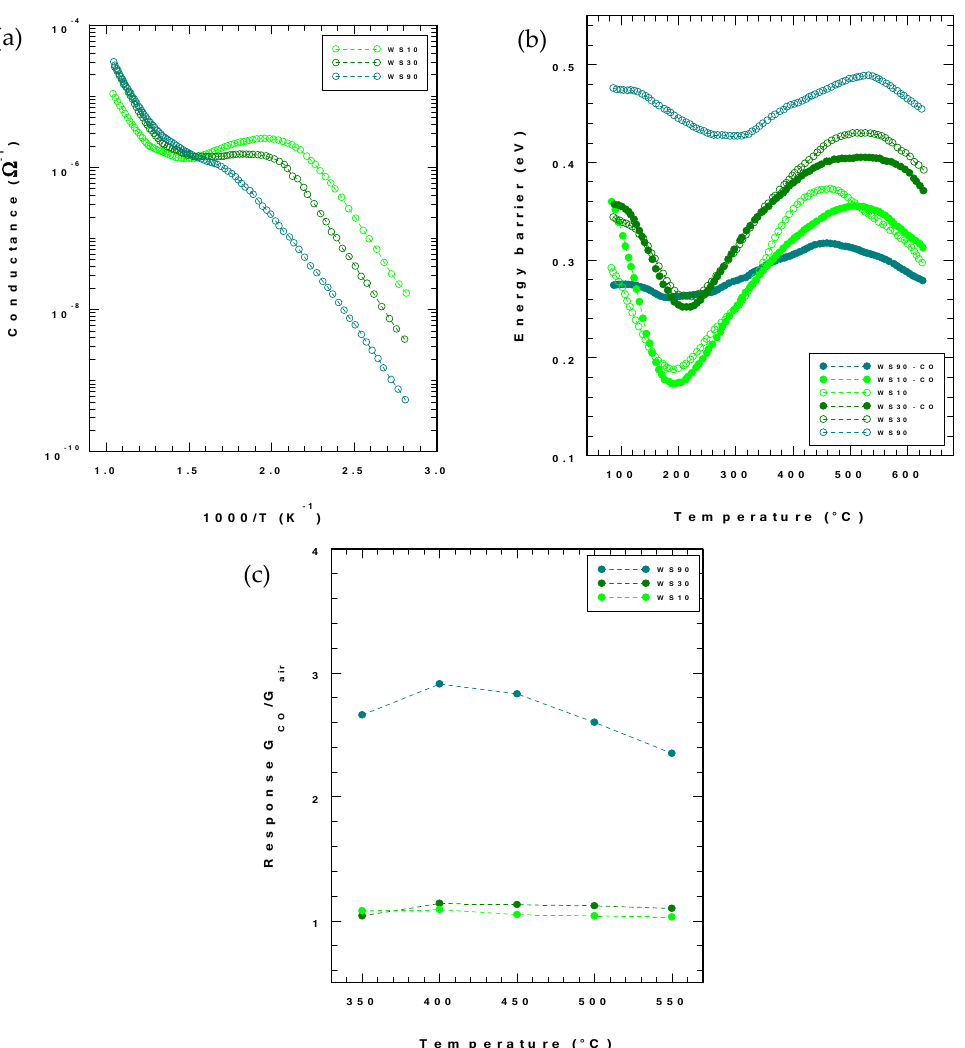
Figure 3. Conductance vs. temperature in dry air ( a ), comparison between the energy barrier dependence on temperature in dry air and in a mixture of dry air and CO (100 ppm) ( b ), responses to 50 ppm of CO reported as G CO /G air obtained at different temperatures ( c ) for W-Sn mixed oxides.